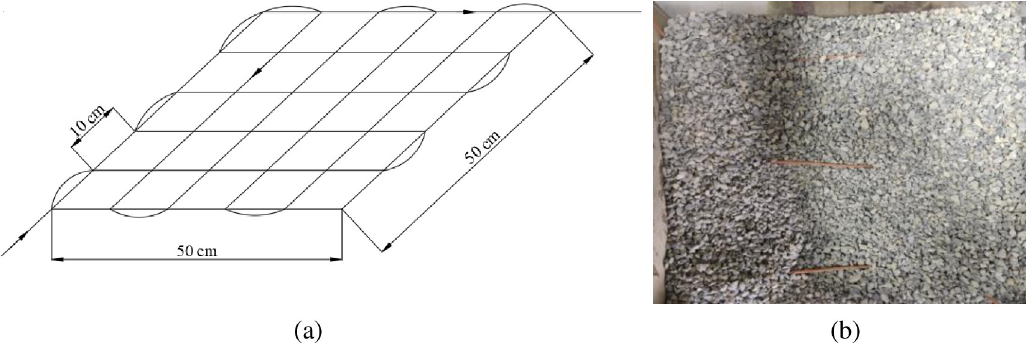
Fig 3. Arrangement method of active heating optical fiber.